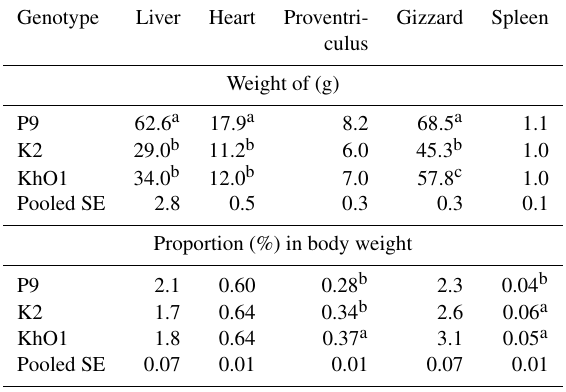
Table 4. Weight and proportion (%) in the body weight of main internal organs in spent